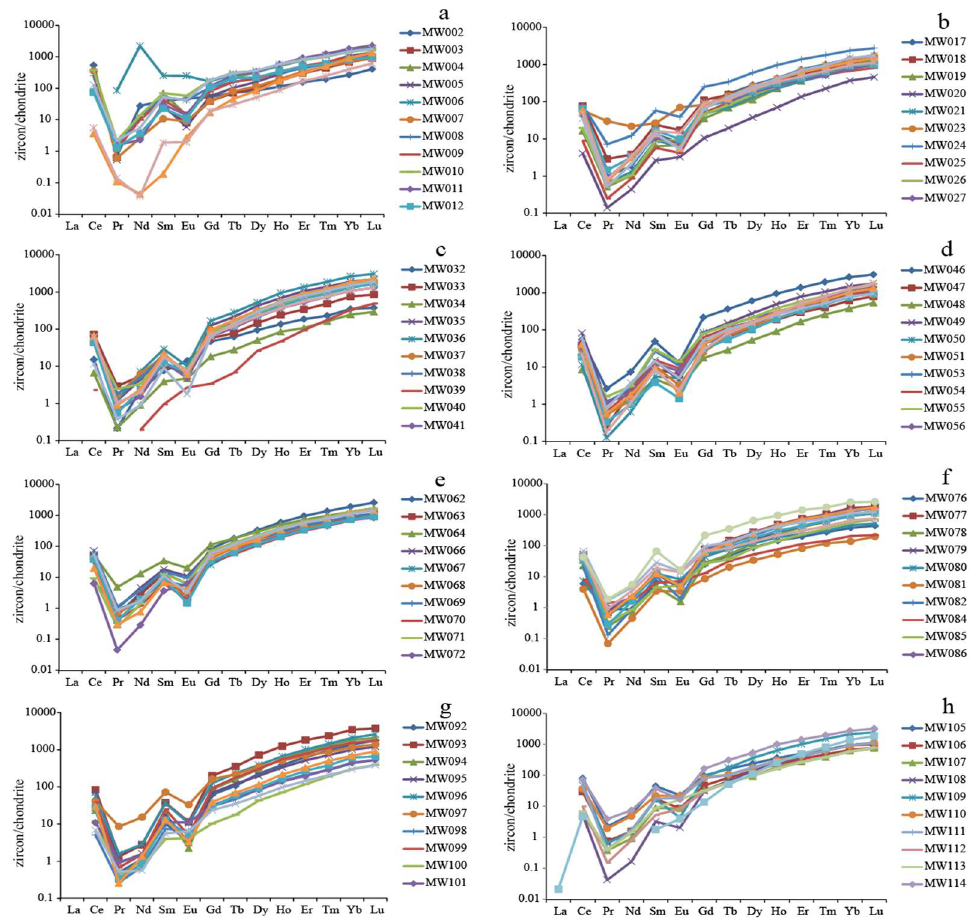
Figure 3. The western Meiganga magmatic zircon grains are normalized to [59] chondrite values and are plotted on Log 10 versus element (La–Lu) diagrams.